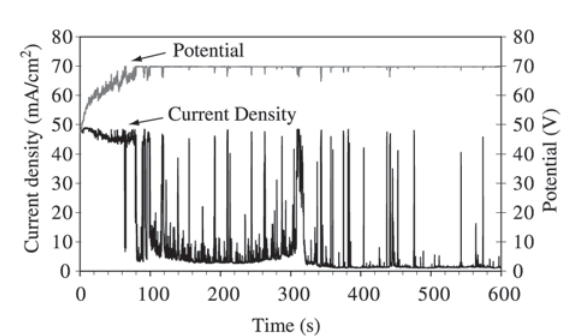
Figure 1. Current density and potential transients during anodization of the AZ91HP alloy in